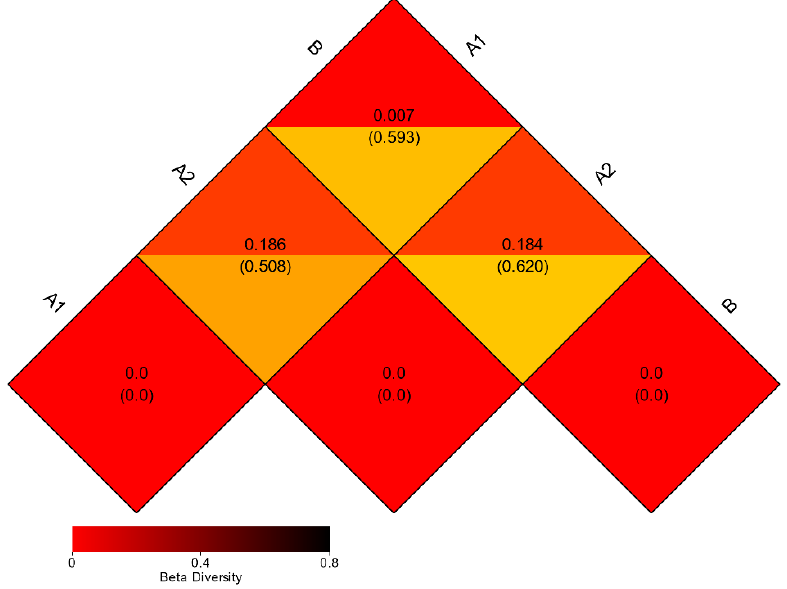
Figure 6. Dissimilarity coefficient heat map among A1, A2 and B samples, based on unweighted UniFrac (lower values, in brackets) and weighted UniFrac distances (upper values).